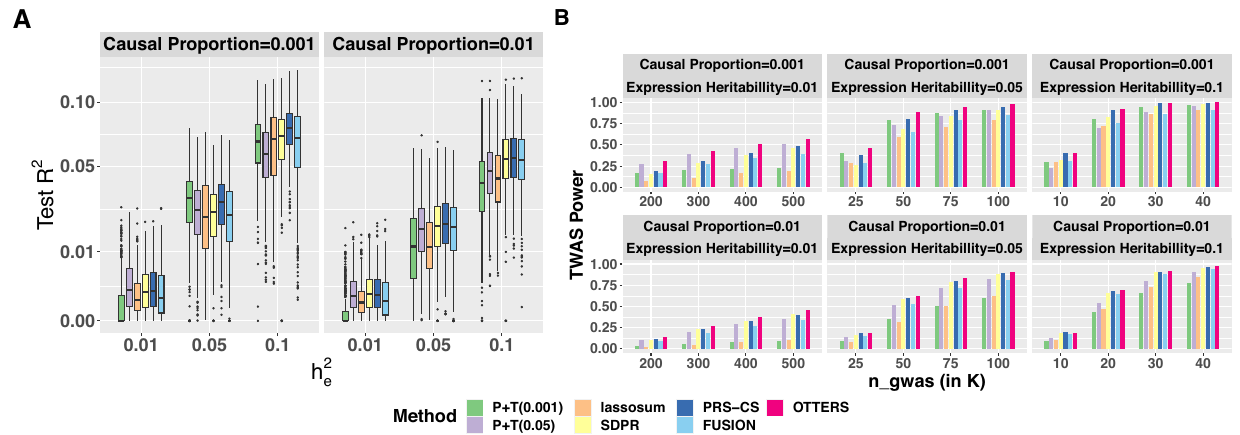
Fig. 2 | Test R 2 (A) and TWAS power (B) comparison in simulation studies. Various scenarios with proportions of true causal cis-eQTL p causal = 0 : 001,0 : 01 ð Þ and gene expression heritability h 2 e = 0 : 01,0 : 05,0 : 1 ð Þ were considered in the simu- lation studies. Distribution of test R 2 in 5000 simulations per method per scenario waspresentedusing box-plot ( A ).The medianwasshownasa blackbar.The lower and upper hinges corresponded to the 25th and 75th percentiles. Whiskers